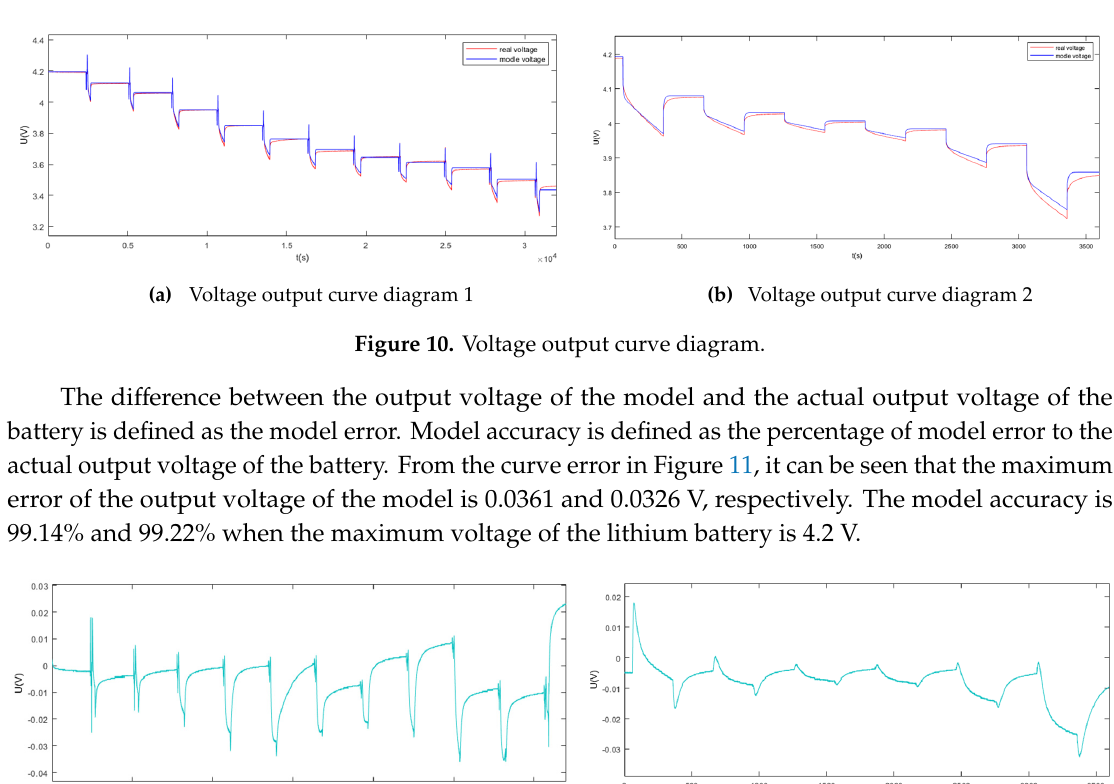
Figure 9. The variable operating current.